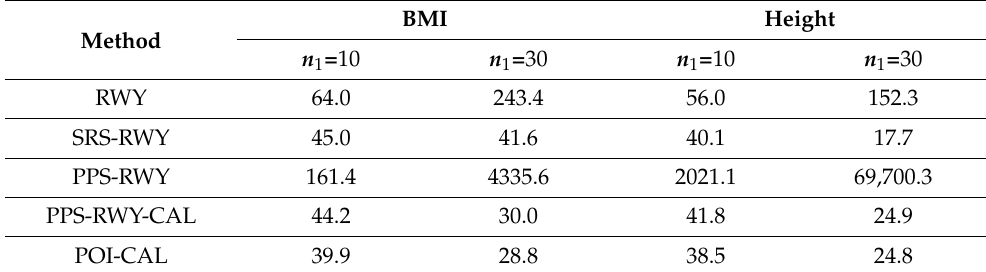
Table 3. The percent relative root mean square errors of the bootstrap variance